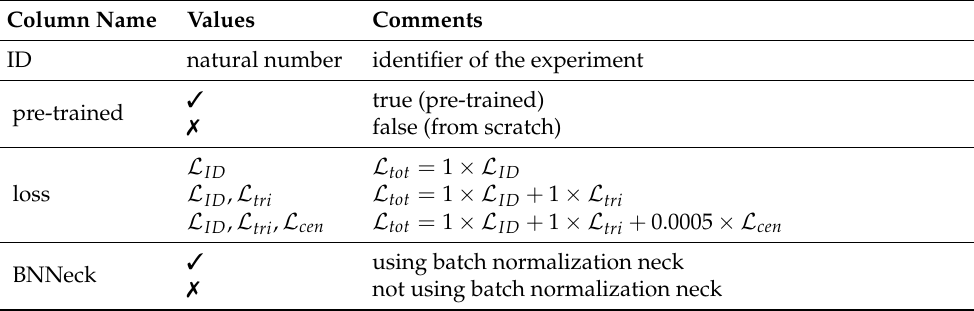
Table 5. Instructions on how to read the different values of the result tables.